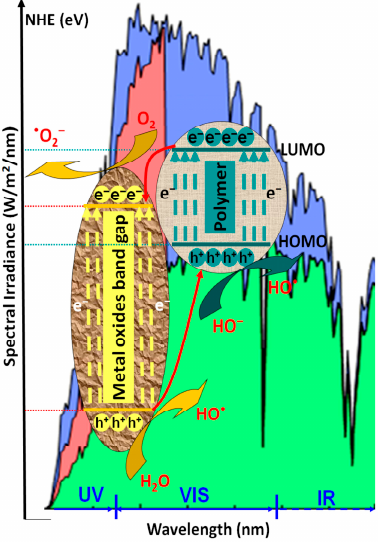
Figure 1. The photocatalytic mechanism of polymeric composites.